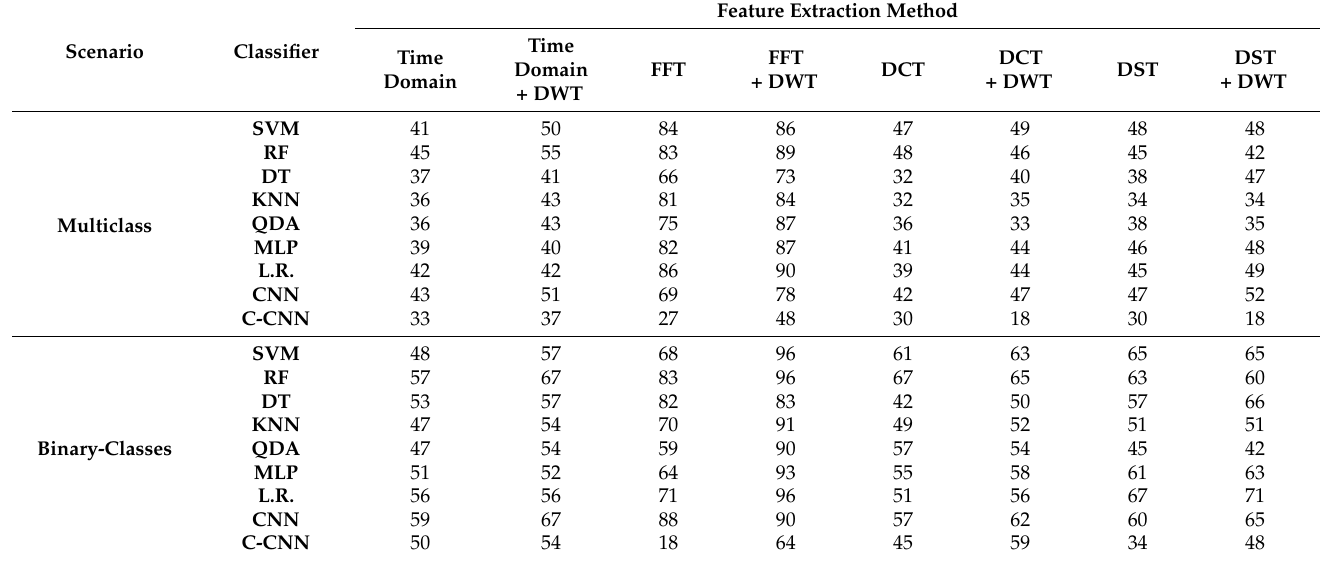
Table 6. Brief Comparison among The Accuracy of The Proposed Machine Learning Models in Different